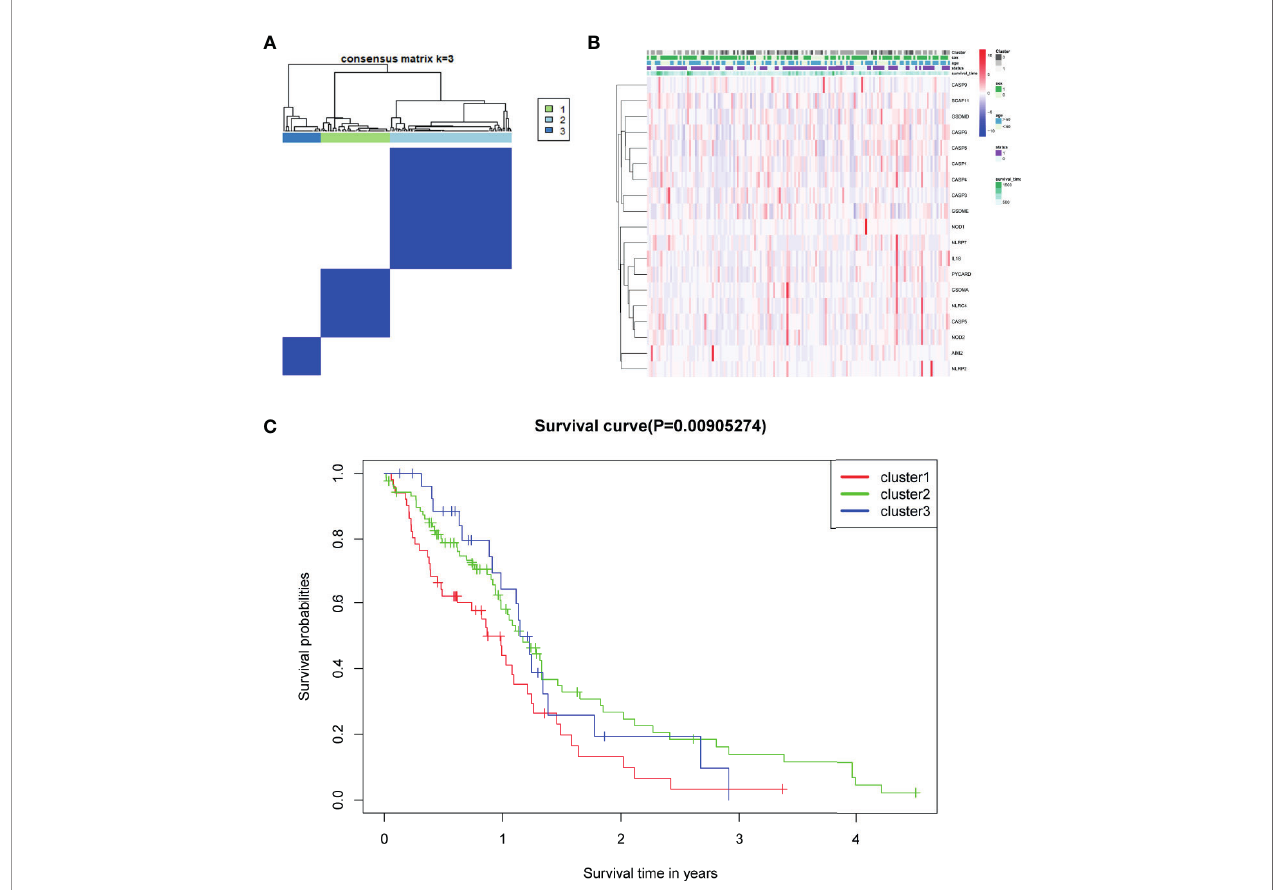
FIGURE 6 | Tumor classi fi cation based on the pyroptosis-related DEGs. (A) One hundred sixty-nine GBM patients were grouped into three clusters according to the consensus clustering matrix ( k = 3). (B) Heatmap and the clinicopathological characters of the three clusters classi fi ed by these DEGs. (C) C Kaplan – Meier OS curves for the three